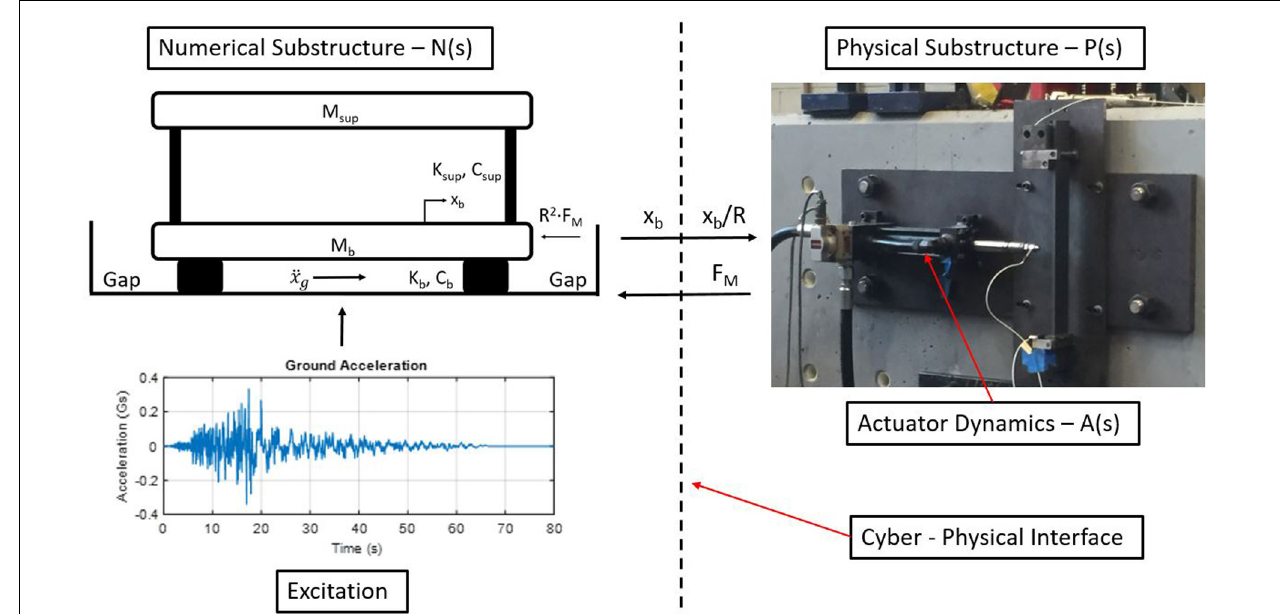
FIGURE 1 | Schematic representation of a real-time hybrid substructure